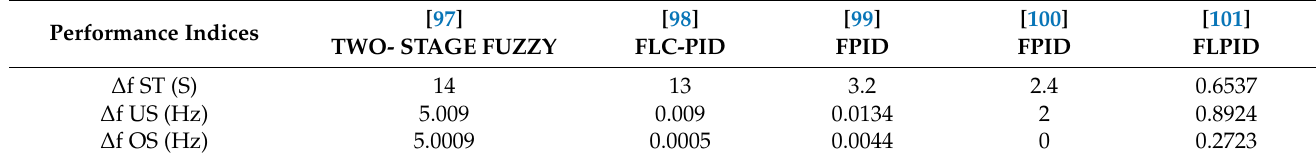
Table 4. Performance Indices of Fuzzy Controller in an Isolated Power System.